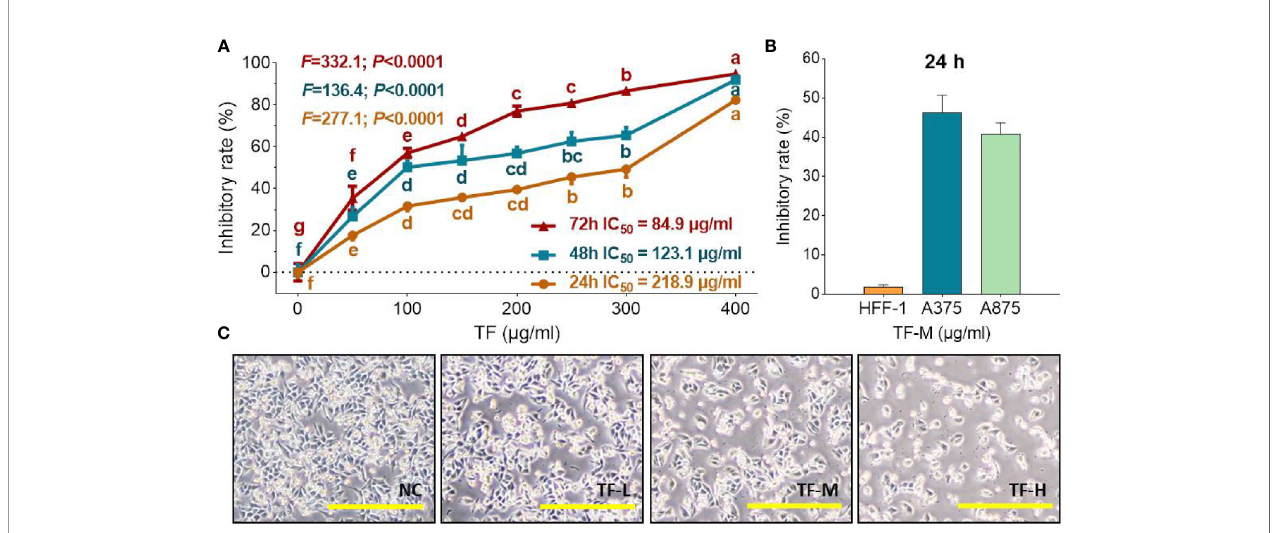
FIGURE 1 | Cell viability of A375 cells with TF treatment at 24, 48, and 72 h (A) , cell viability of HFF-1, A375, and A875 cells with TF treatment at 24 h (B) , and morphology of A375 cells with thea fl avin (TF) treatment at 24 h (C) . Data were mean ± SD ( n = 5). By means of Fisher ’ s least signi fi cant difference (LSD) multiple comparisons, data (mean ± SD) with same lowercase letter (b vs. bc; bc vs. cd; c vs. c; cd vs. d; d vs. d) indicate no signi fi cant difference between each other, while data with different letters (a vs. b vs. c vs. b vs. e vs. f vs. g) indicate signi fi cant difference with each other. Scale bar = 200 m